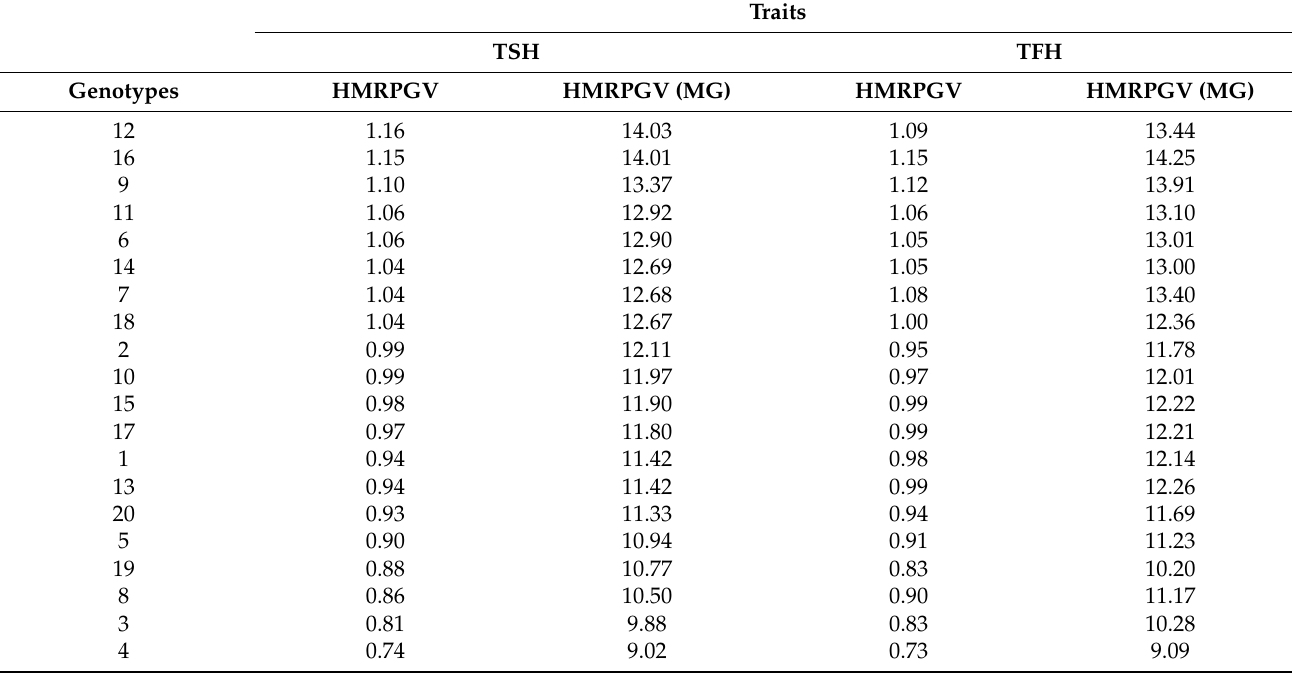
Table 8. Adaptability and stability (HMRPGV and HMRPGV *GM) of genotypic values of sugarcane genotypes, with prediction by the analysis of the best unbiased linear predictor (BLUP), evaluated in five sugarcane microregions of the State of Pernambuco, in the sugarcane and two sugarcane harvest